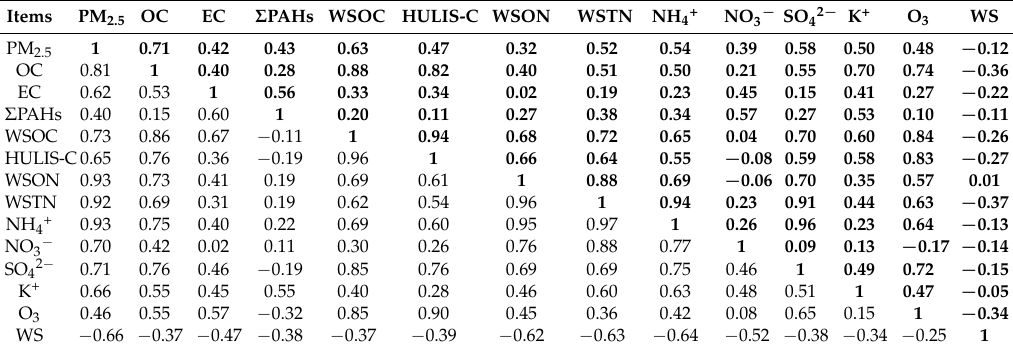
Table 2. Correlation coefficient ( r ) between components in PM 2.5